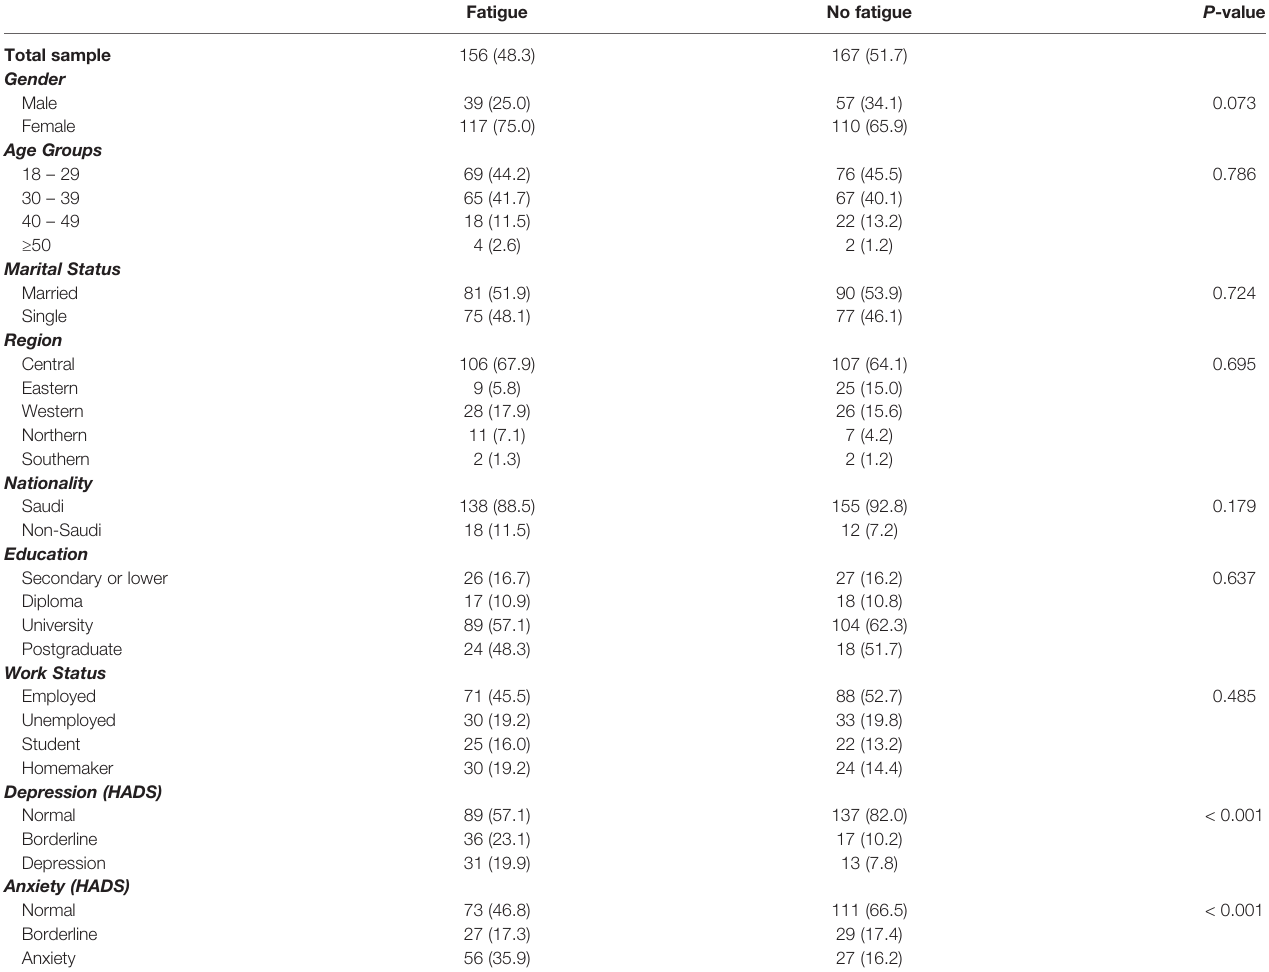
TABLE 4 | Fatigue in multiple sclerosis patients of the total sample and by demographic characteristics, depression, and